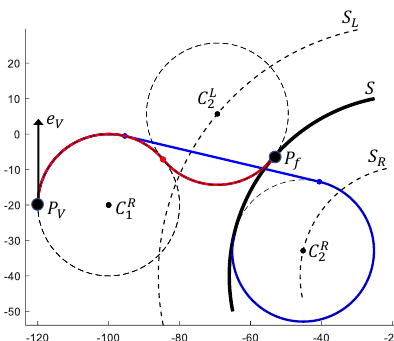
Figure 7. An example of building a Dubins path that connects point P v with arc S . For this example,